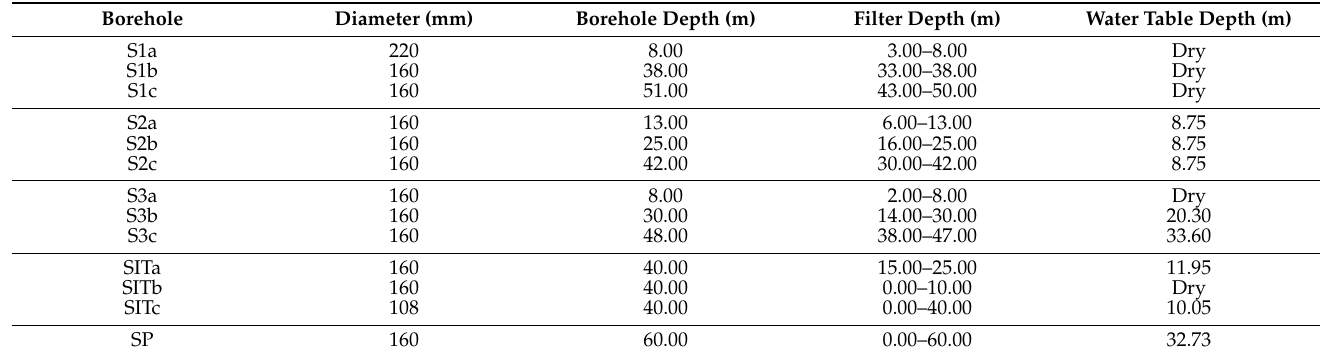
Table 1. Geometrical characteristics of the boreholes drilled into the aquifer and water table depths measured during the spring